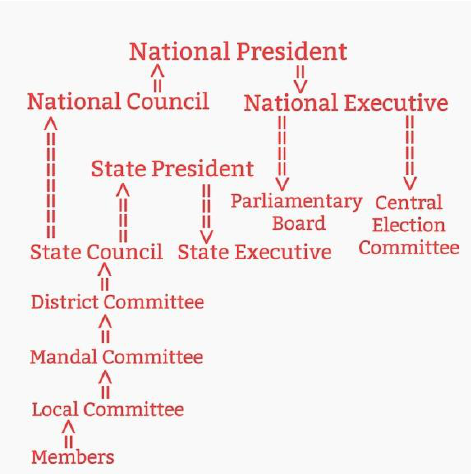
Figure 2: BJP‘s Organisational Structure (Source: Organisation of the Bharatiya Janata Party